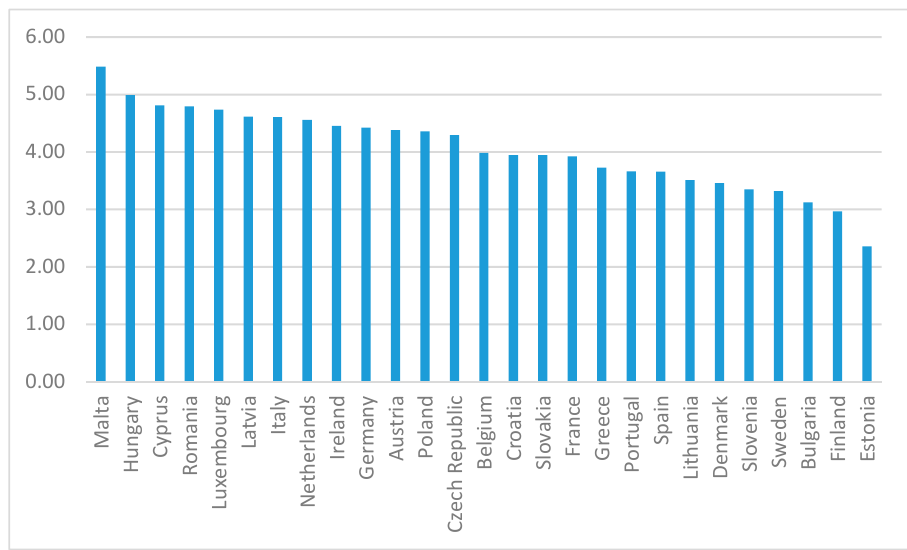
Figure 3. The risk of money laundering in European Union countries, 2020. Source: Authors’ procedure based on data from Basel Institute of Governance (2020).